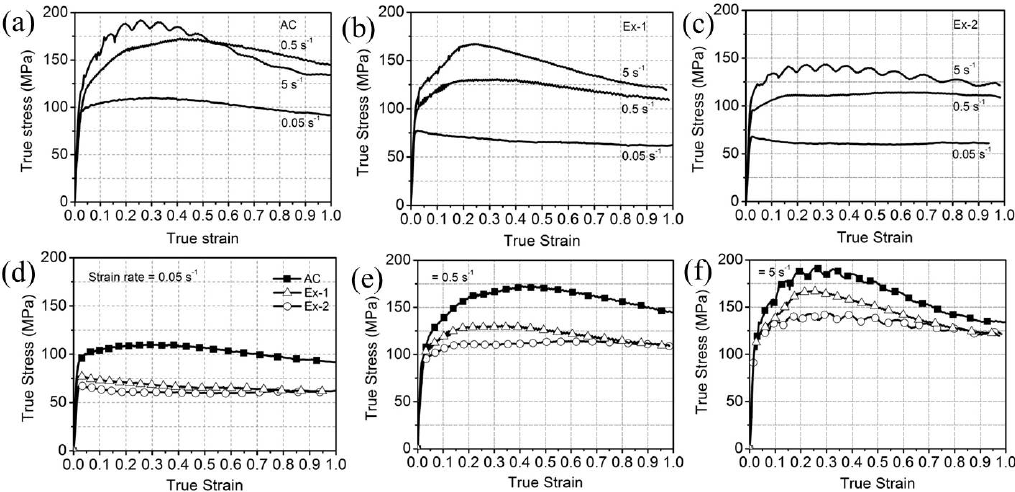
Figure 7. True stress–true strain curves at various strain rates of 0.05-5 s − 1 with a constant temperature of 400 ◦ C for the ( a ) AC, ( b ) Ex-1, and ( c ) Ex-2 WE43 alloy, respectively. Their comparisons at a strain rate of 0.05 s − 1 , 0.5 s − 1 , and 5 s − 1 are shown in ( d ), ( e ), and ( f ), respectively.